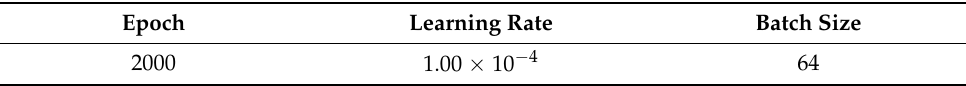
Table 2. Crucial parameter settings for the proposed trajectory prediction